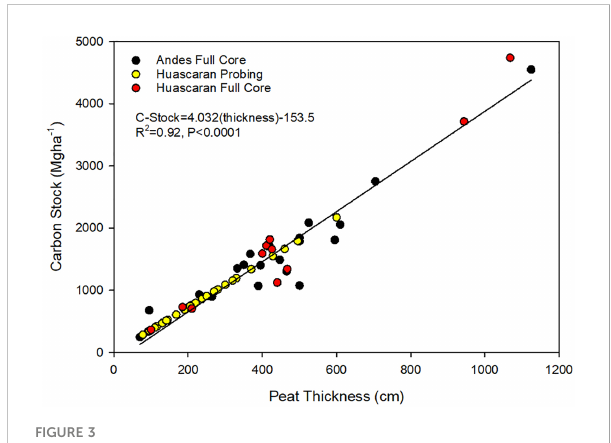
FIGURE 3 Correlation between full peat cores from across the Andes (black circles: Hribljan et al., 2023), full cores from this study (red circles), and probe values from this study (yellow